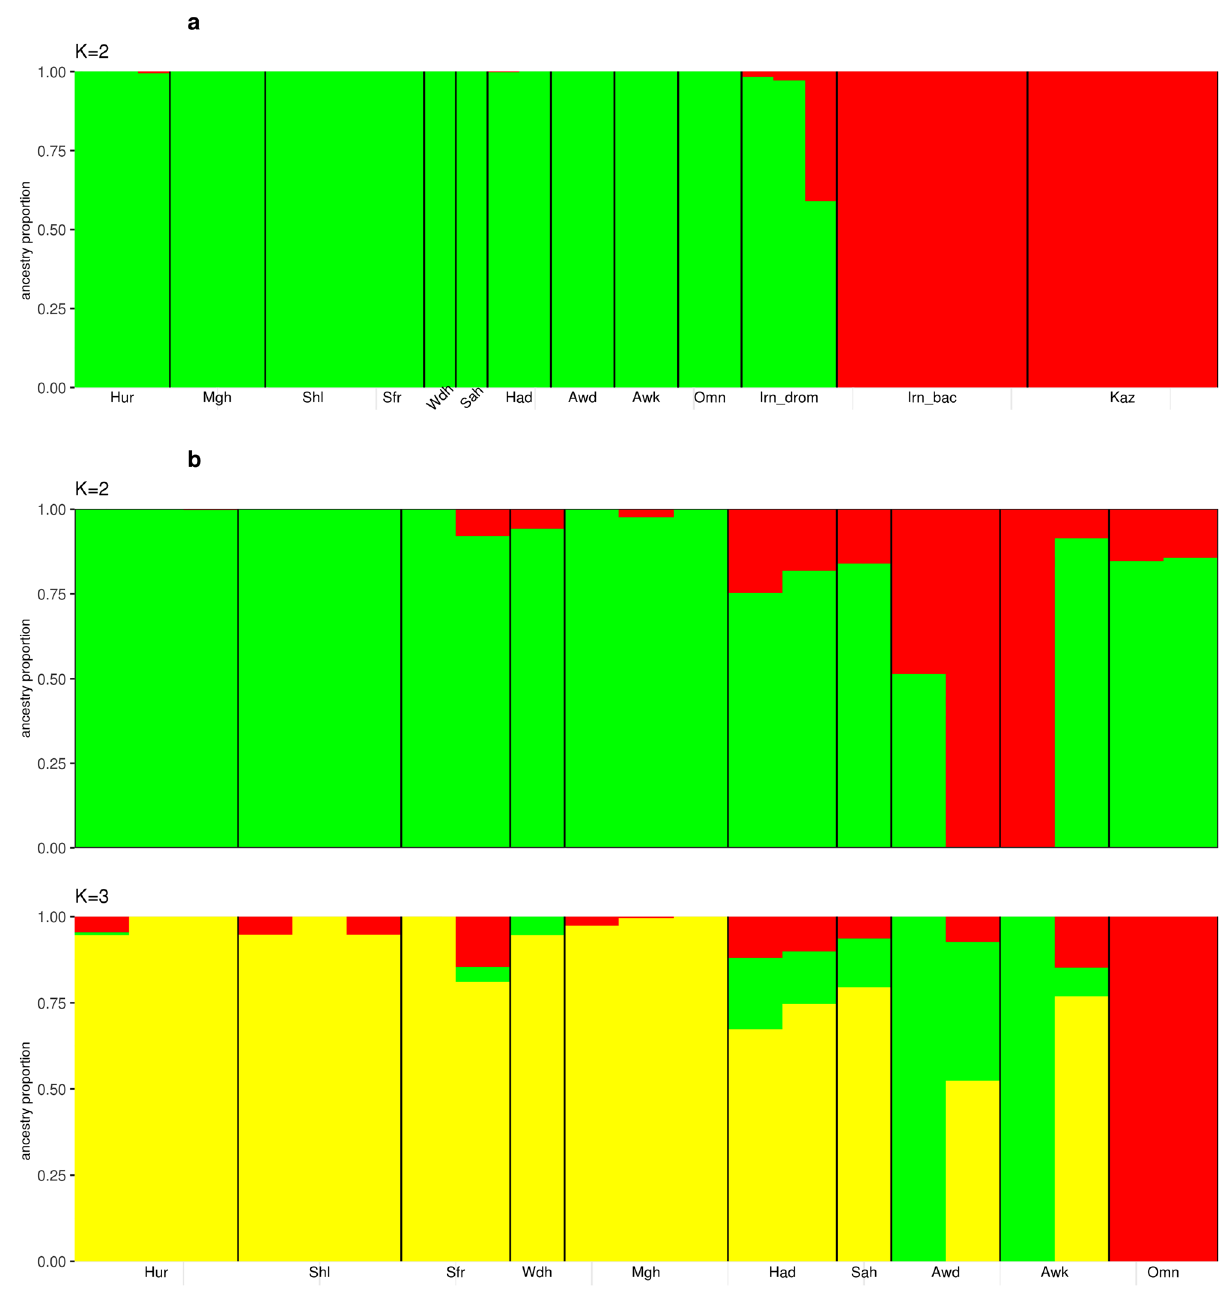
Figure 2. Admixture analysis plots of ( a ) K = 2 on the dromedary and Bactrian camels (dataset 1) and ( b ) K = 2 and 3 on the dromedary camels from the Arabian Peninsula (dataset 2). Hur Hurra, Mgh Magaheem, Shl